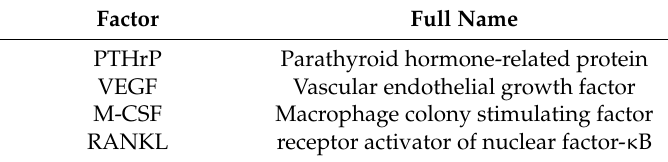
Table 2. PRL-regulated factors in the mammary gland, known to have a role in the bone. Factor